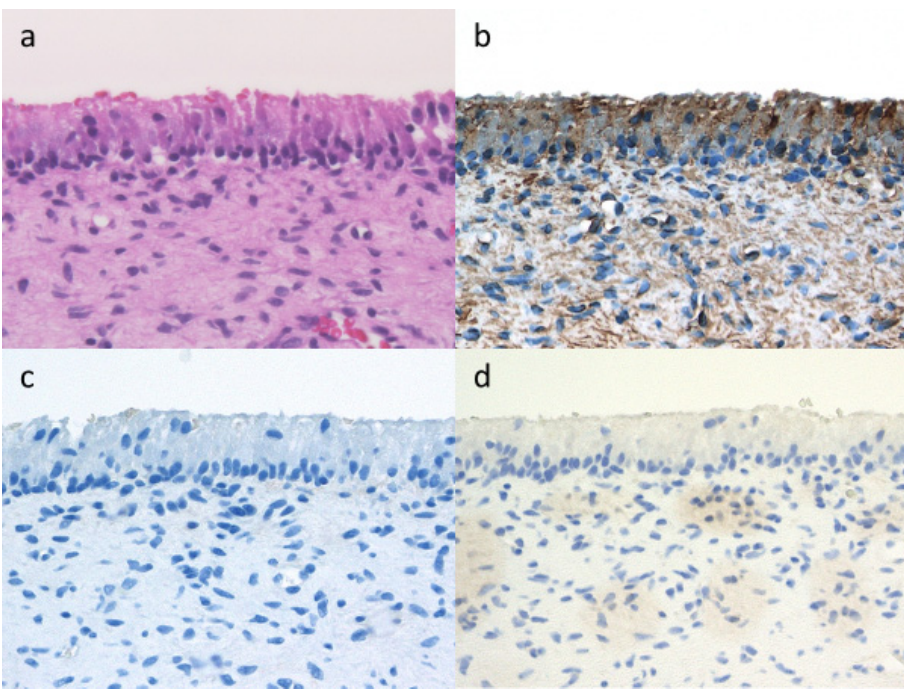
Figure 5. Immunohistochemical findings of primordial odontogenic tumor. ( a ) Hematoxylin and eosin staining (200×). ( b ) Vimentin expressed in the epithelium and mesenchymal cells (200×). Epithelium and mesenchymal cells did not express syndecan-1 ( c ) or Bcl-2 ( d ) (200×).